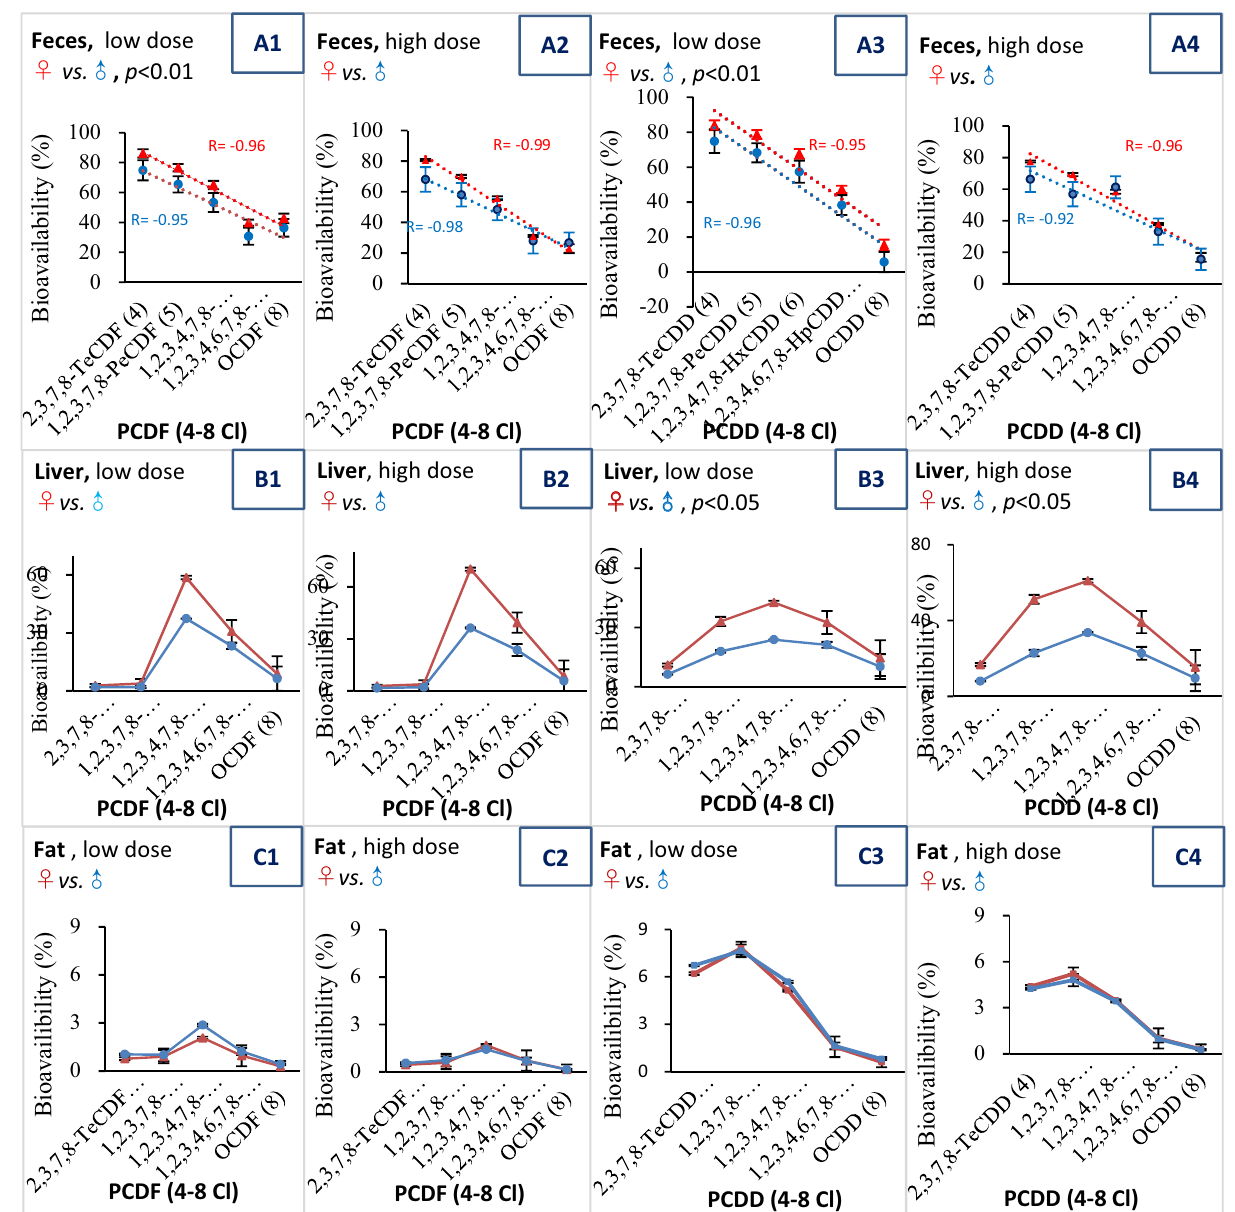
Figure 1. PCDD/F bioavailability measured by different endpoints. Female ( ♀ ) data were presented in red and male ( ♂ ) data in blue. R: Pearson’s correlation coefficient; For PCDD/F: low dose: 0.2 ng/100 g b.w./d; high dose: 1 ng/100 g